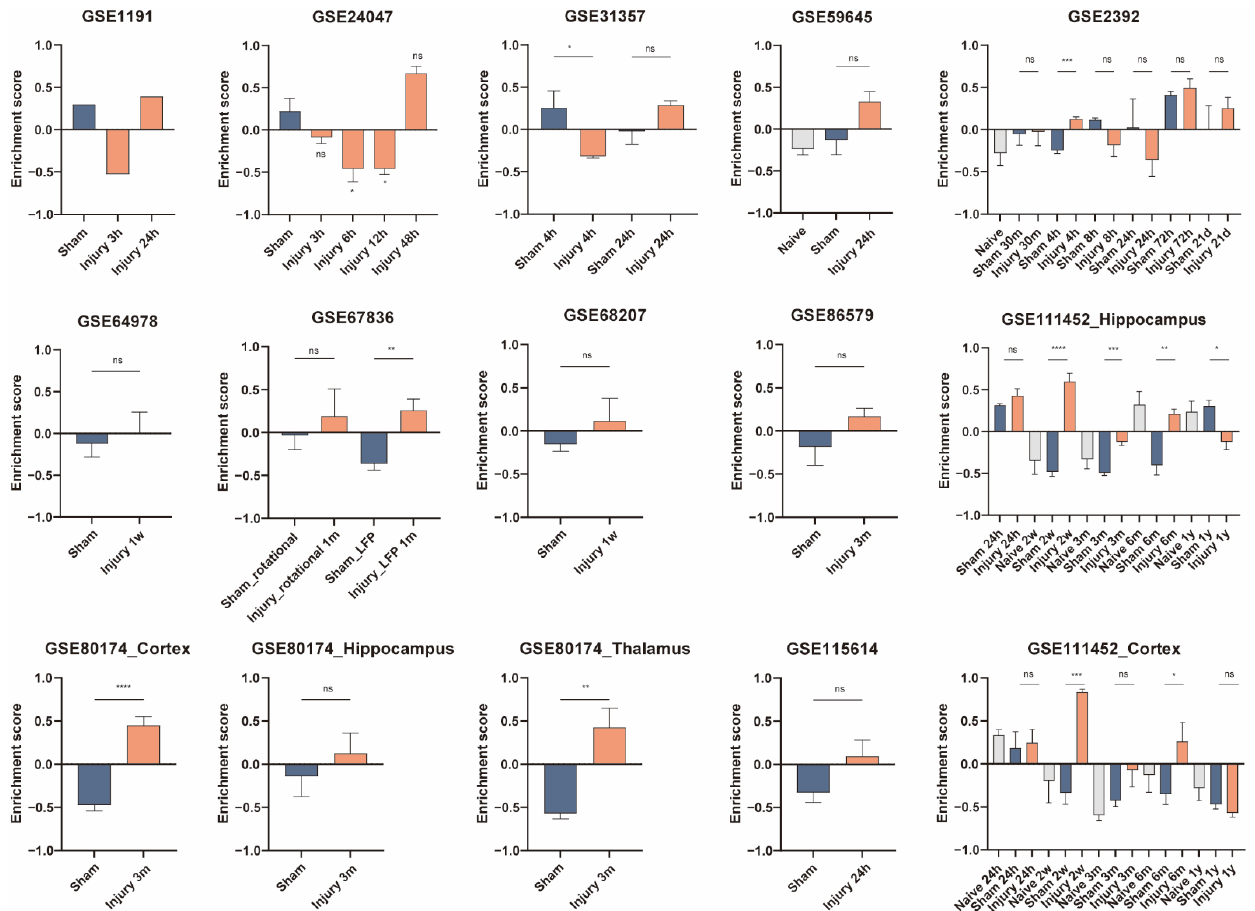
Figure 5. Gene set variation analysis (GSVA) for microglia in the validation datasets. GSVA enrichment scores from the validation data sets are plotted as bar graphs. The GEO accession number of the dataset is labeled in each panel. Samples from multiple regions in one dataset are compared separately. Information is labeled in the corresponding panels if the dataset contains samples with different treatments or harvested at various postinjury time points. For GSE1911, N = 1 for each group; for GSE24047, N = 4 for Sham group and N = 3 for the other groups; for GSE31357, N = 4 for each group; for GSE59645, N = 2 for Sham group and N = 3 for Naïve group and Injury 24-h group; for GSE2392, N = 3 for Naïve, Injury 4-h, Injury 8-h, Injury 24-h, Injury 72-h, and Injury 21-d groups, N = 4 for Sham 30-m and Sham 4-h groups, N = 5 for Injury 30-m group, N = 2 for Sham 8-h, Sham 24-h, Sham 72-h, and Sham 21-d groups; for GSE64798, N = 5 for each group; for GSE67836, N = 4 for Sham_LFP group and N = 3 for the other groups; for GSE68207, N = 4 for each group; for GSE86579, N = 5 for Sham group and N = 6 for Injury 3-m group; for GSE111452_Hippocampus, N = 2 for Sham 24-h group, N = 3 for Injury 24-h group, and N = 4 for the other groups; for GSE80174_Cortex, GSE80174_Hippocampus, and GSE80174_Thalamus, N = 5 for each group; for GSE115614, N = 2 for Sham group and N = 3 for Injury 24-h group; for GSE111452_Cortex, N = 4 for each group. **** p < 0.0001, *** p < 0.001, ** p < 0.01, * p < 0.05. Data are shown as means ±